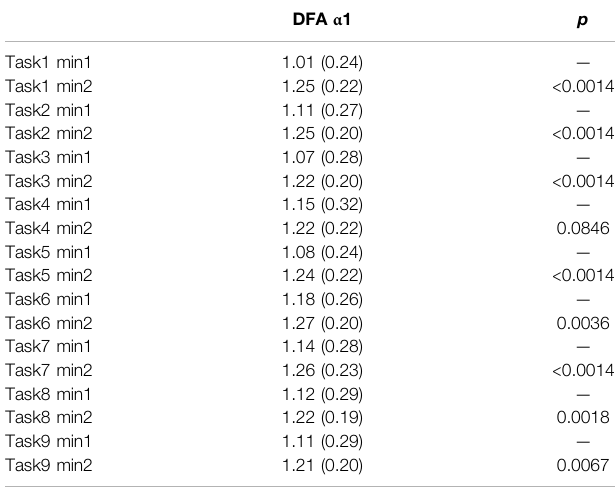
TABLE 5 | DFA α 1 one-minute comparison within tasks. All numbers except TABLE 6 | DFA α 1 comparisons between 24-hour and (viewing or task). p -values p -values are presented as mean (SD). are reported in comparison with 24-hour DFA α DFA α 1 p Task1 min1